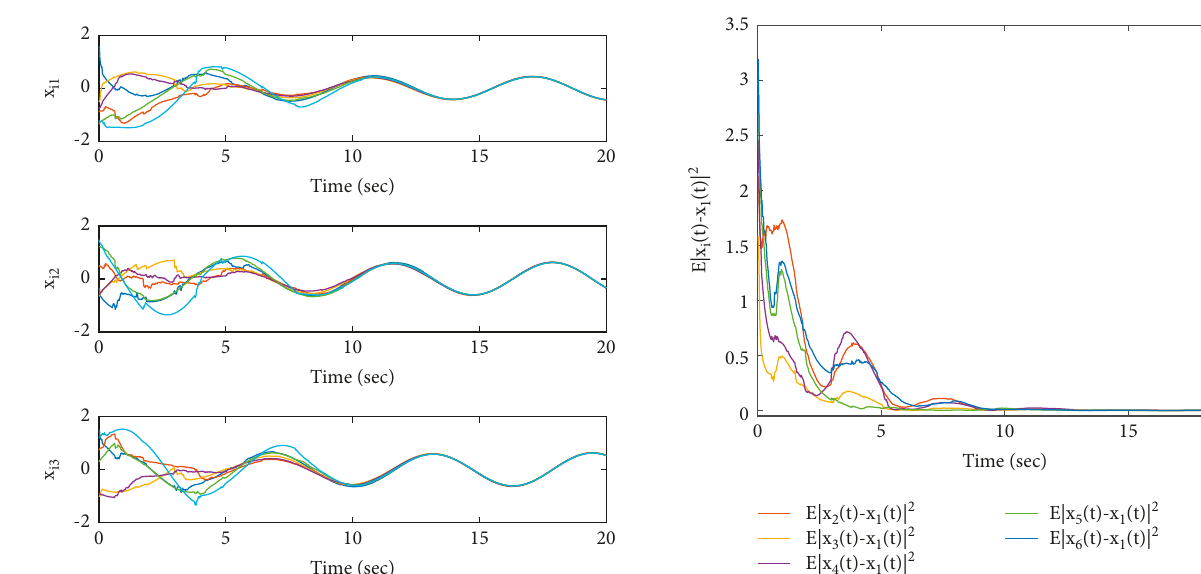
Figure 5: States of the 6 agents in Example 2. Figure 7: Mean square errors E | x